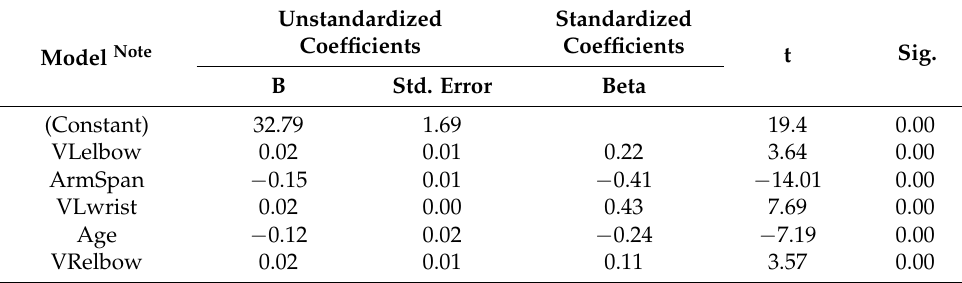
Table 10. Results of stepwise regression of